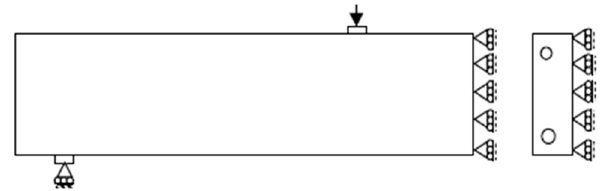
Figure 7. Symmetry boundary conditions used in the FE simulation.